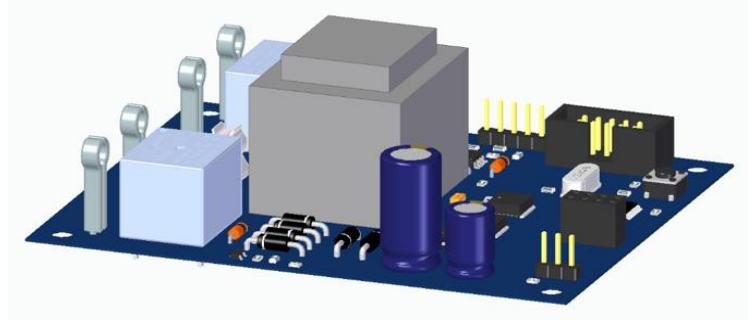
Fig. 1. 3D-model of the production object – an electronic module of the room temperature control system.